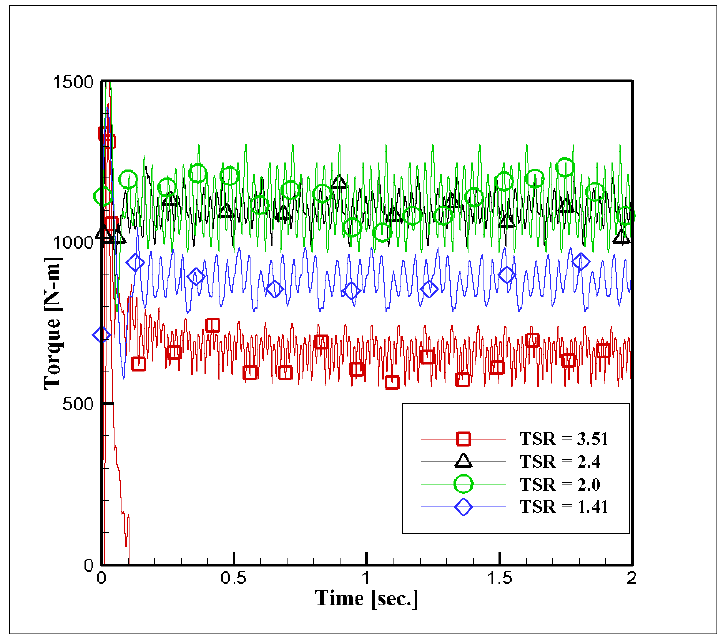
Figure 11. Time history of torque on the turbine.